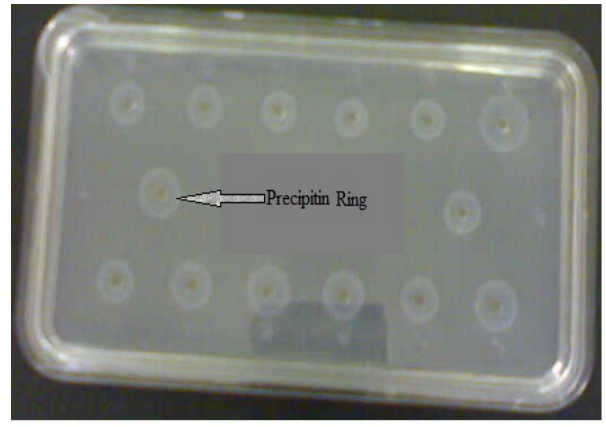
Figure 1. RID plates showed varied precipitin rings.